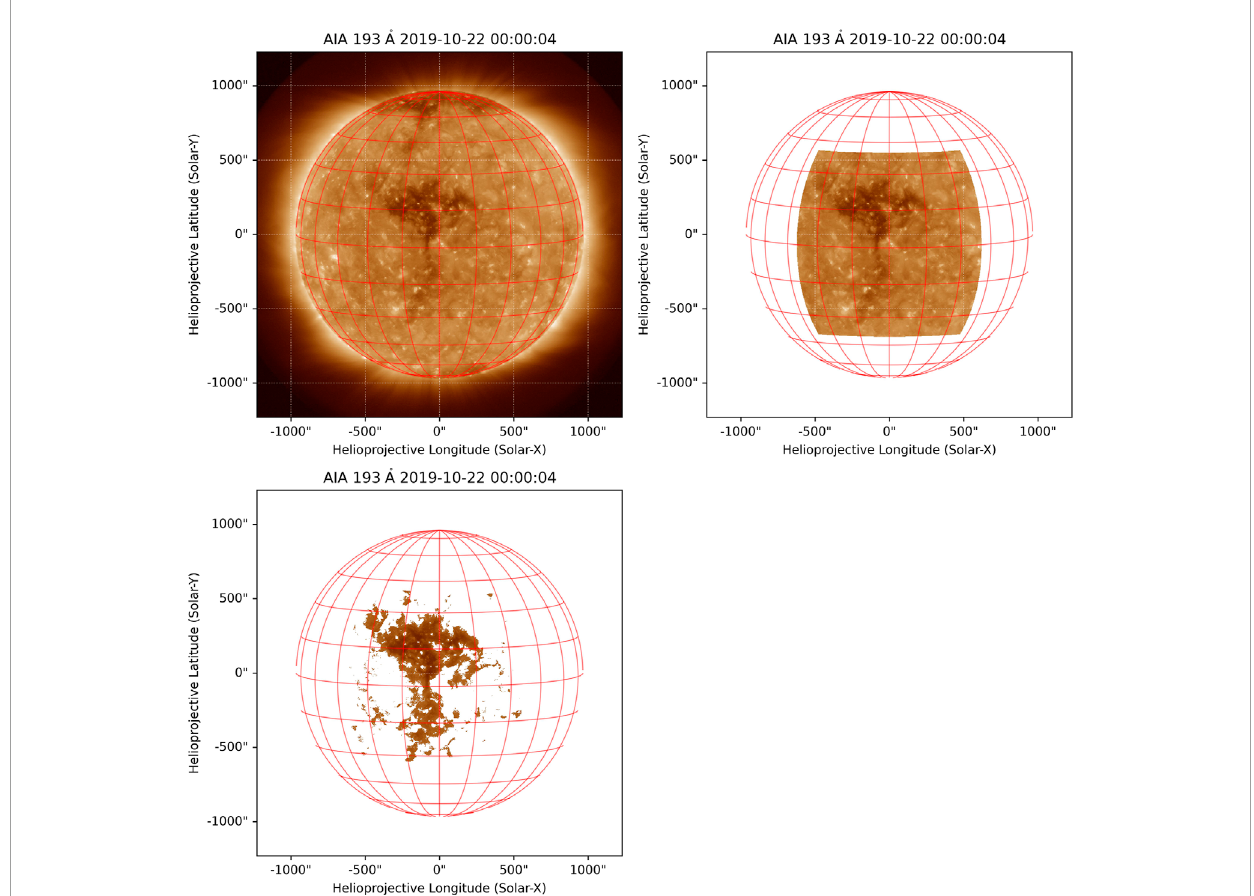
FIGURE 3 Illustration of preparing the AIA 193Å images. The upper left shows the 193Å images at 00:00:04 UTC on 22 Oct 2019 measured using SDO/AIA. The upper right shows the cut slice covering the [ S 40 , N 40 ] and [ E 40 , W 40 ] areas. After all values above the median in the slice are replaced by 0, the pre-processed slice referring to the coronal holes is shown in the bottom